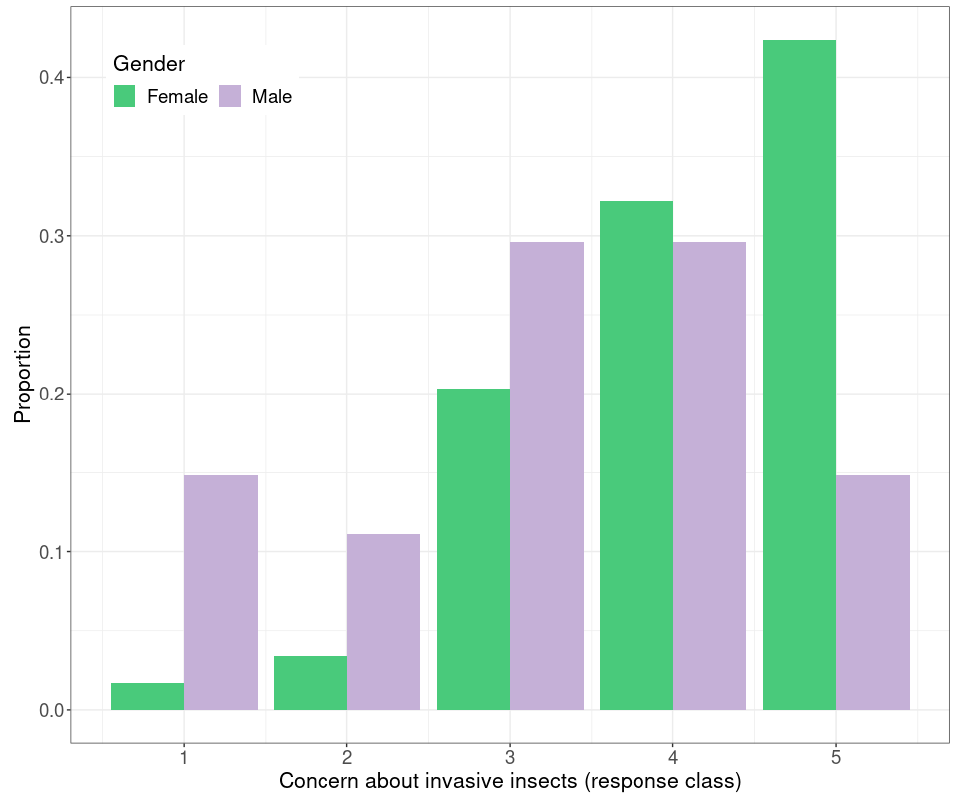
Figure 2. Proportion of respondents with different levels of concern about invasive pest insect species by gender. The scale ranges from 1 to 5 (1 = not very concerned, 5 = very concerned).